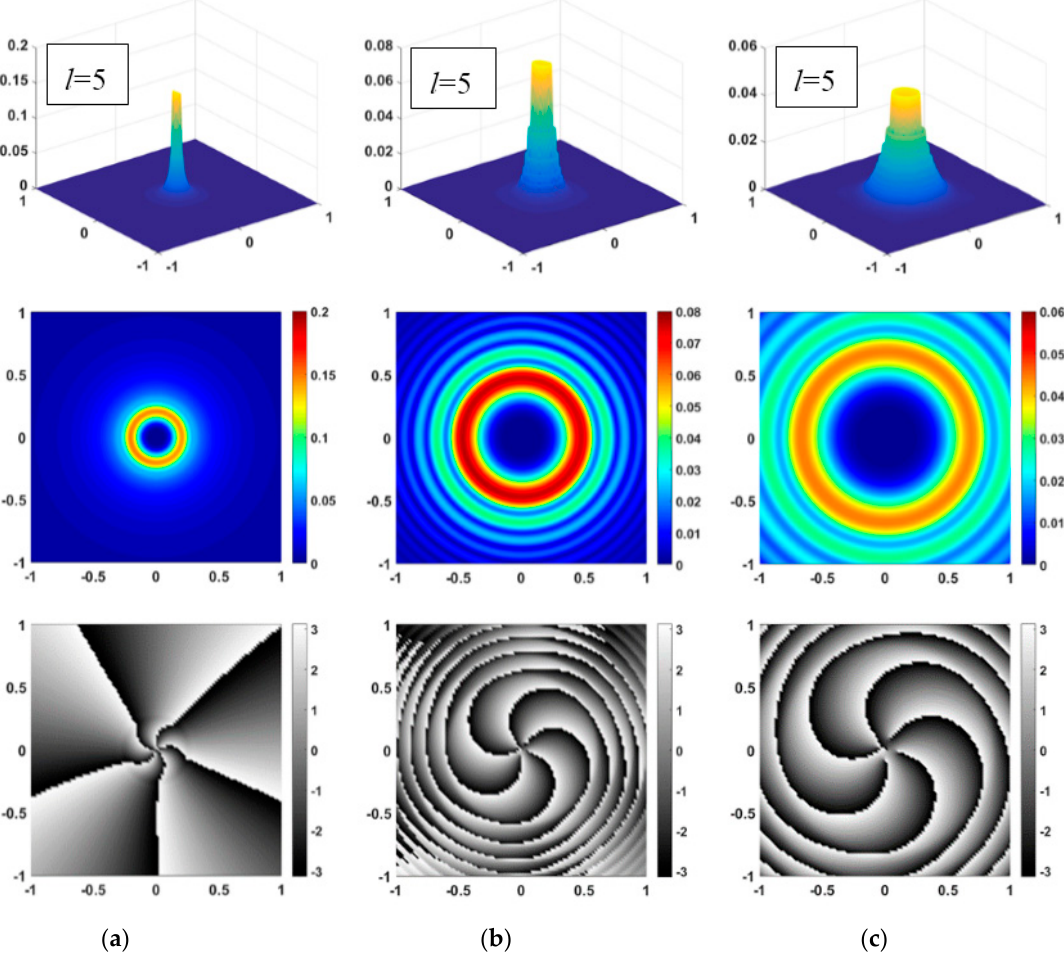
Figure 1. Intensity and phase distribution of electromagnetic vortex waves with transmission distance ( a ) 1 km, ( b ) 5 km, and ( c ) 10 km through ideal conditions.